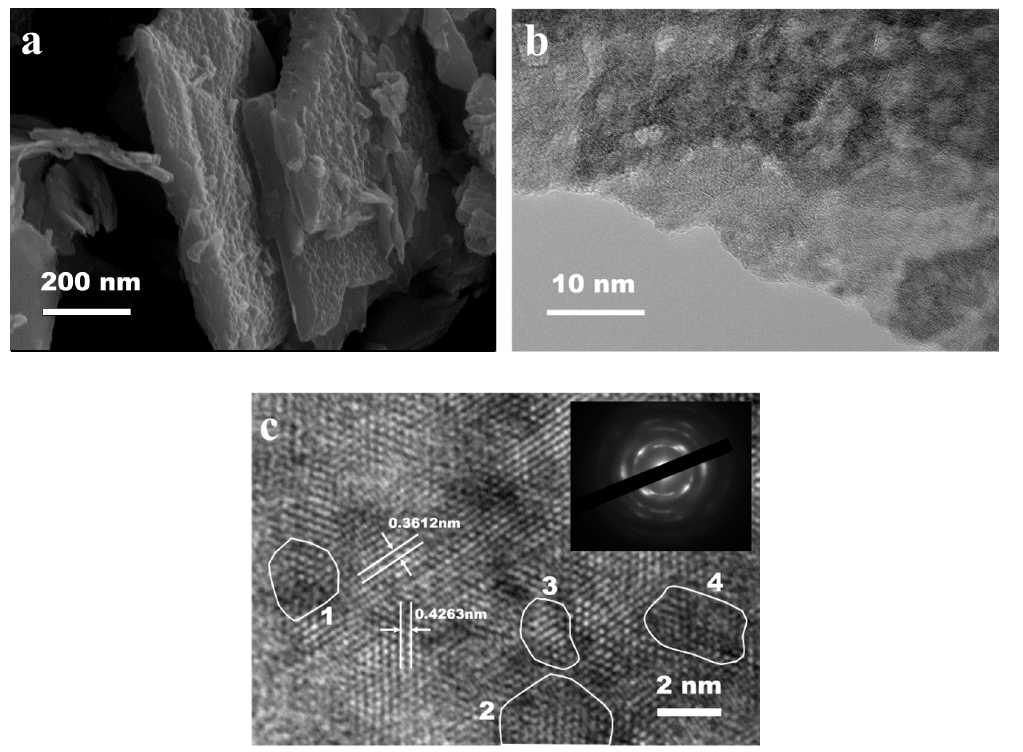
Figure 2. The morphology characterization of NaBiS 2 . (a) SEM pattern; (b) low magnified TEM graph; (c) high magnified TEM graph, with nano-domains labelled.